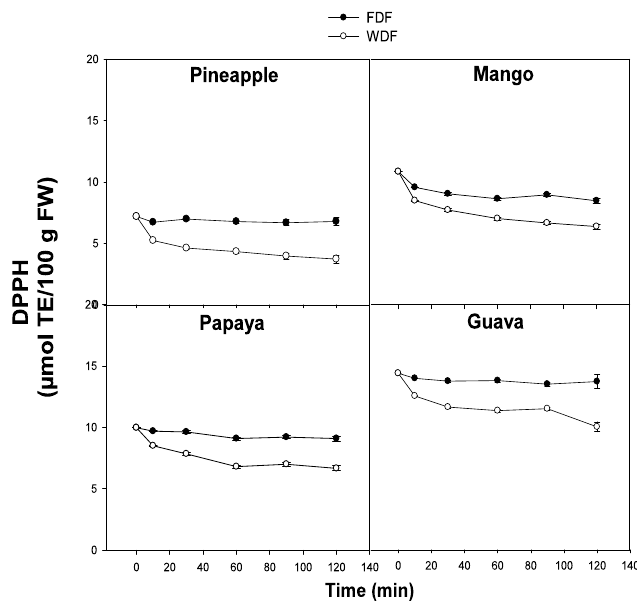
Fig. 5: Antioxidant capacity depletion of methanolic extract (ME) by add- ing fruit dietary fiber (FDF) and wheat dietary fiber (WDF) respect to